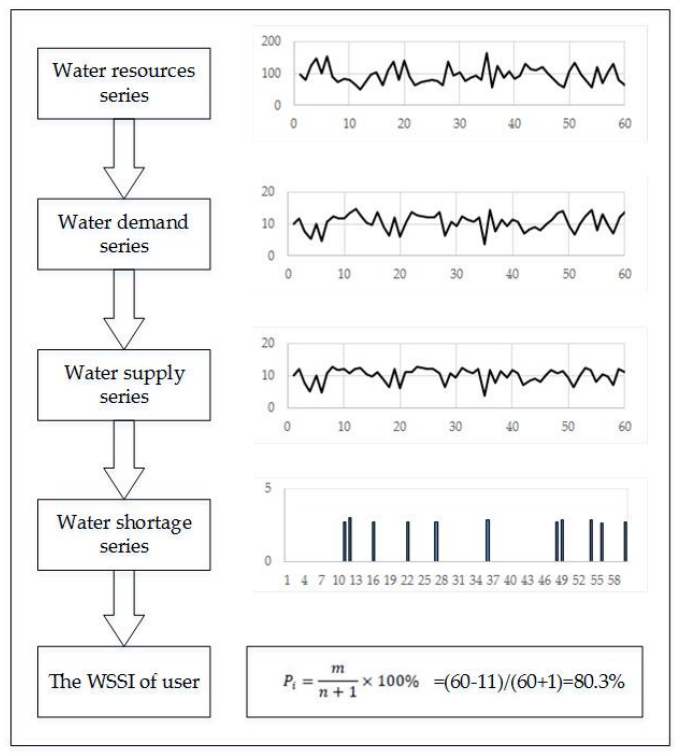
Figure 3. Calculation diagram for the Water Supply Security Index (WSSI).